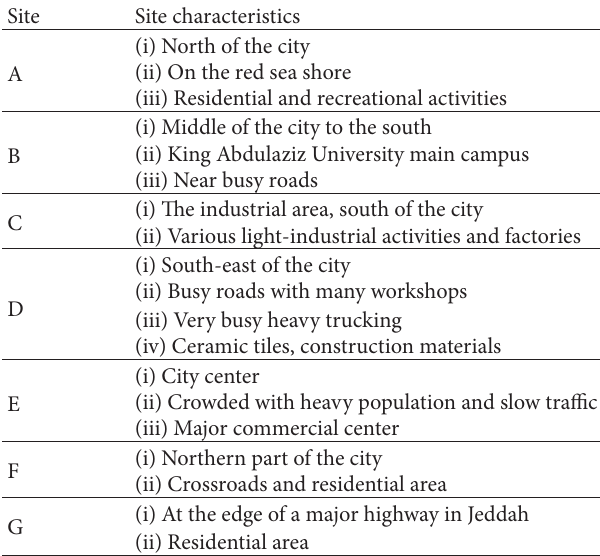
Table 1: Sampling site characteristics.